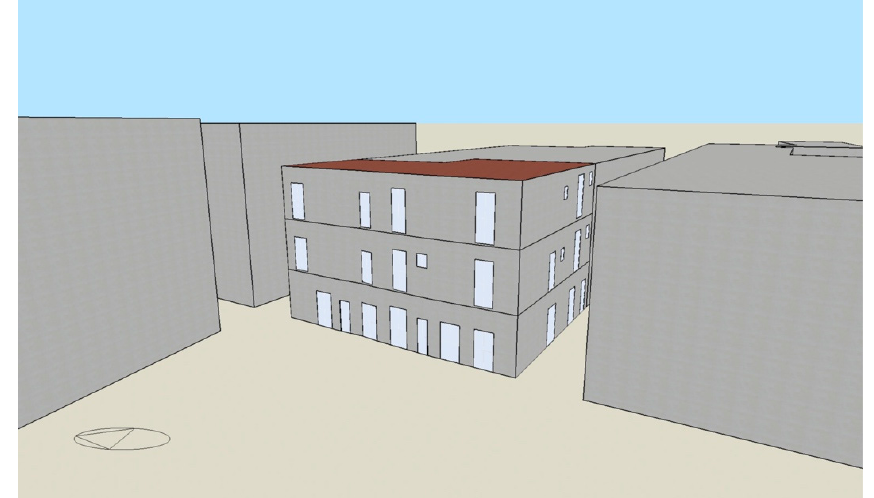
Figure 4. Rendered view of the selected building and surroundings.